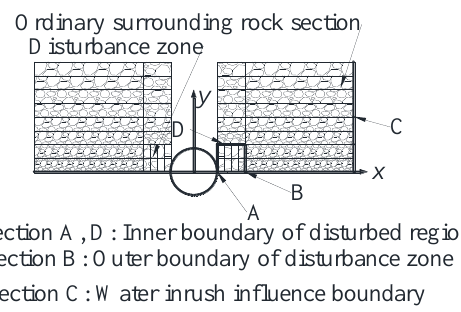
Figure 1. Space simplified model of permeability of surrounding rock.